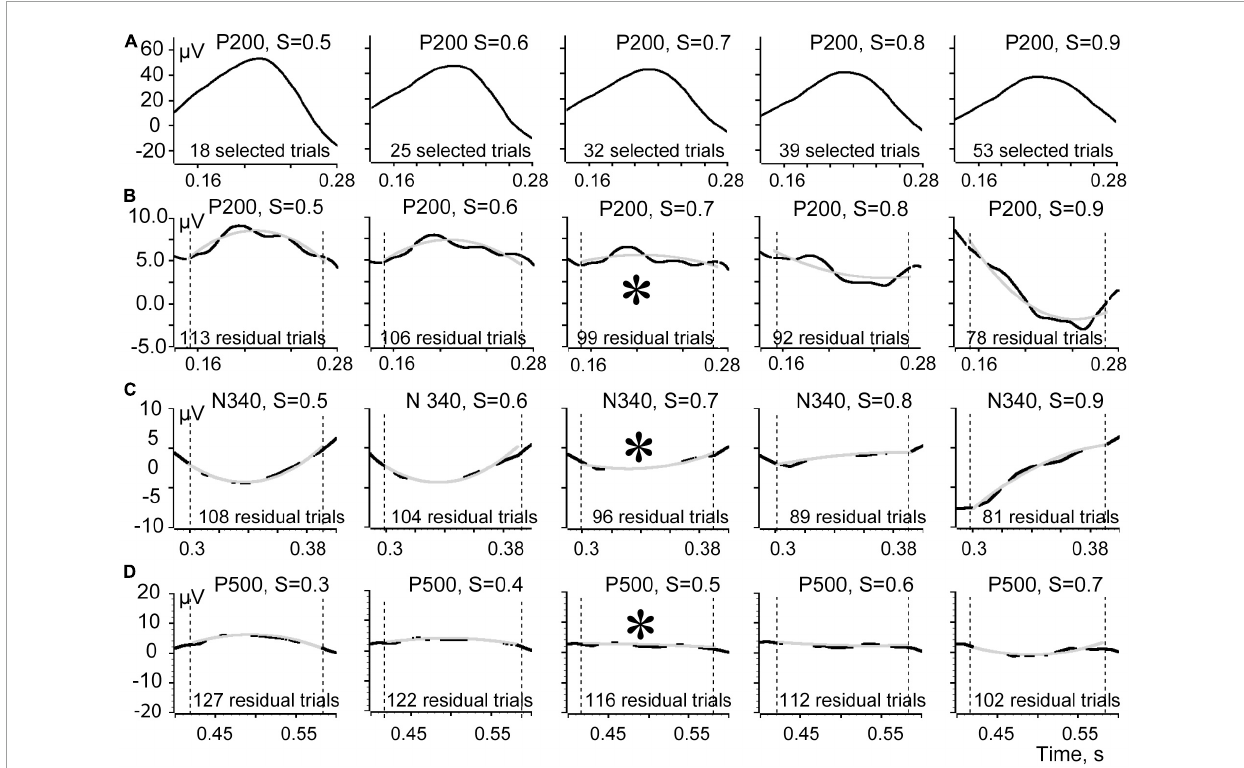
FIGURE5 Shapes of the evoked response components averaged for efficient and residual trials. (A) Shapes of the P200 component averaged using efficient trials markers corresponding to S ranging from 0.5 to 0.9. (B) Shapes of the averaged residual signal for the corresponding thresholds for the P 200 component. (C) Averaged residual signals for N 340. (D) Averaged residual signals for P 500. Asterisks signify the S values corresponding to the least deflection of the averaged residual signal from 0.